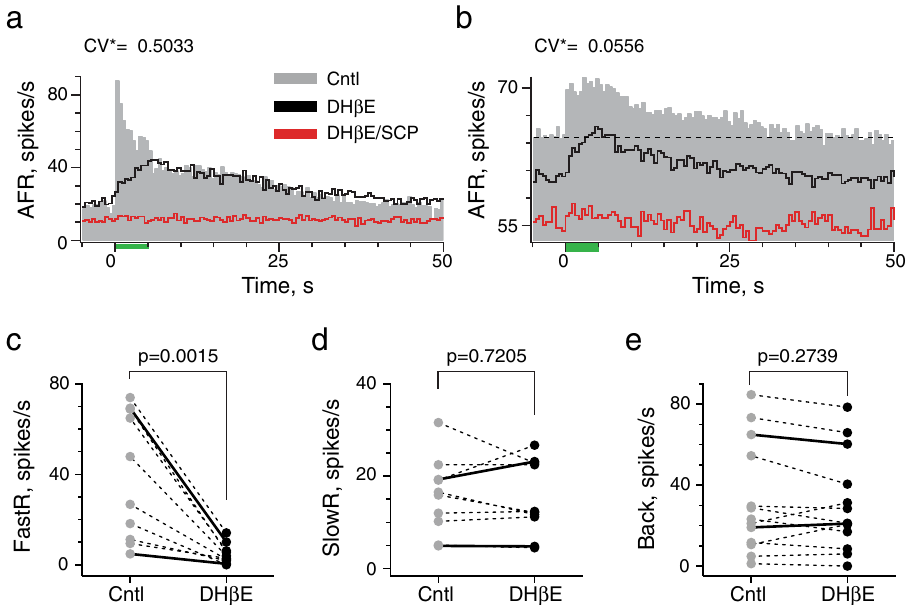
Figure 7. Efferent-mediated fast excitation is selectively blocked by the nicotinic ACh receptor antagonist DHβE. ( a,b ) Average response histograms from an irregularly- and regularly-discharging afferent during ipsilateral stimulation, respectively, before (gray, Cntl) and after serial administration of DHβE (black, 1.4 mg/ kg) and scopolamine (red, SCP, 1 mg/kg). Binning in panels ( a , b) is 500 ms. ( c,d ) Values of mean peak fast (FastR) and slow excitation (SlowR) for ten units before and after DHβE. The range and mean doses were 1.4–5 mg/kg and 3.5 mg/kg, respectively. ( e ) Values of mean background discharge rates for 13 individual units before and after DHβE application. Examples shown in panel ( a , b) appear as solid lines in panels ( c–e) . Indicated p value from comparisons made using a paired t test.